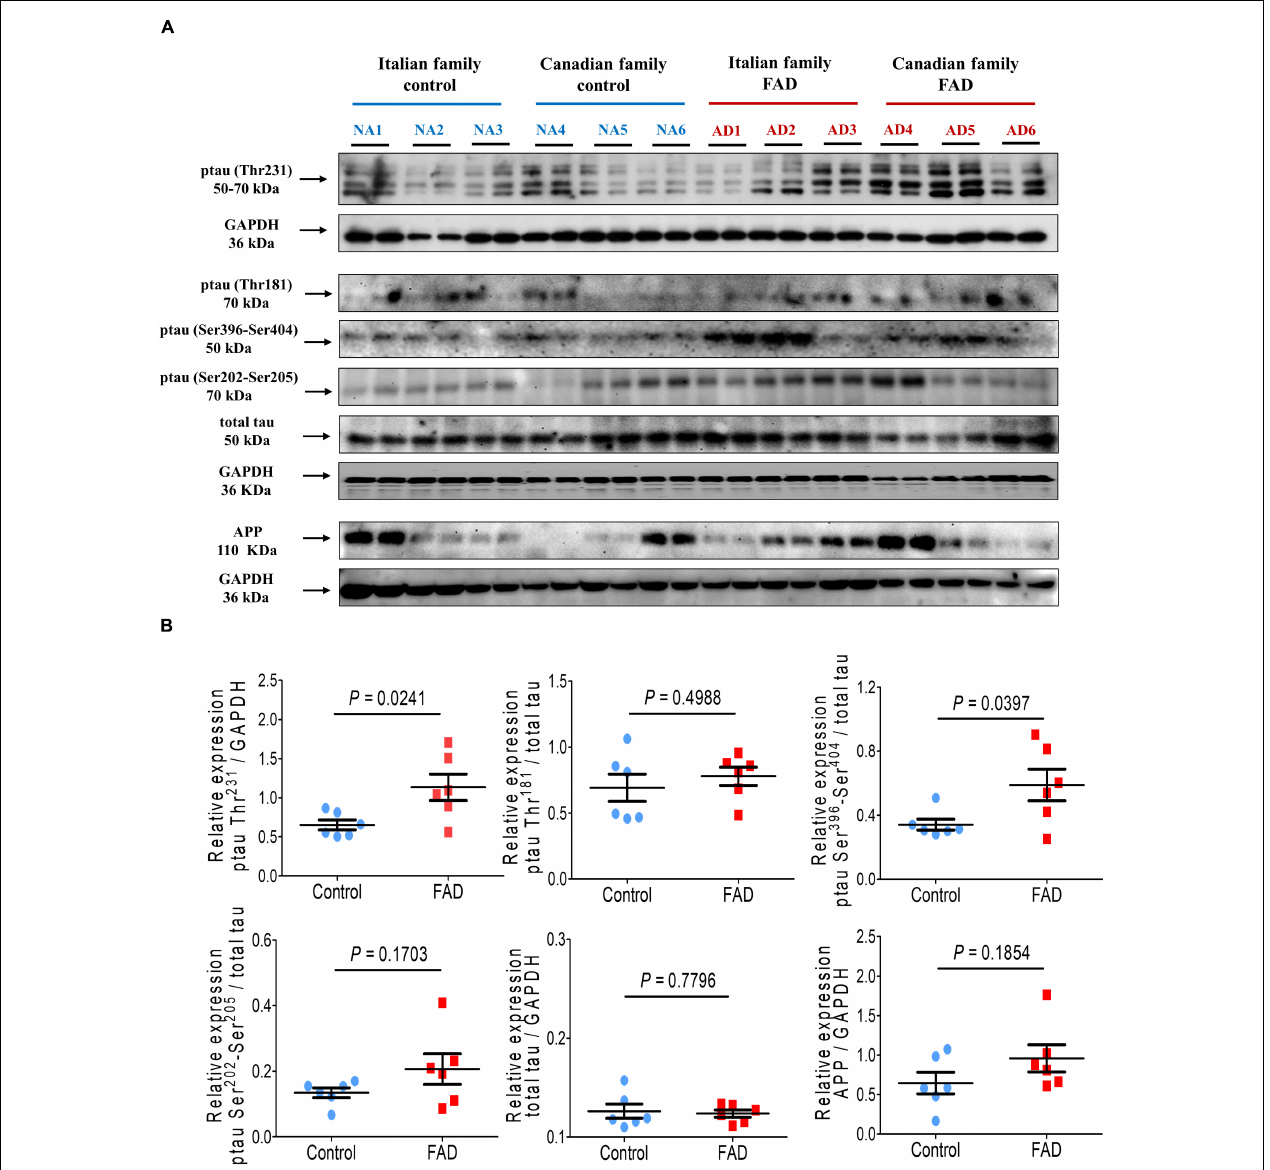
FIGURE 4 | Immunodetection of the Amyloid β protein precursor (A β PP) and the pathological phosphorylation of the protein tau (Thr 231 , Thr 181 , Ser 404 , and Ser 396 ) in fibroblasts from FAD individuals and control subjects (NA). Proteins were evaluated by Western blotting. (A) Blots for fibroblast protein extracts from control (6) and FAD (6) individuals. Samples were analyzed in duplicate. (B) Analysis of A β PP, p-tau-Thr 231 , p-tau-Thr 181 , p-tau Ser 396 -Ser 404 and total tau levels. The amount of A β PP and total tau was normalized with GAPDH, and phosphorylation of tau protein was normalized with total tau levels. Points on the graphs represent the average value of the duplicates for each sample. Statistical analysis in (B) was performed with Student’s t